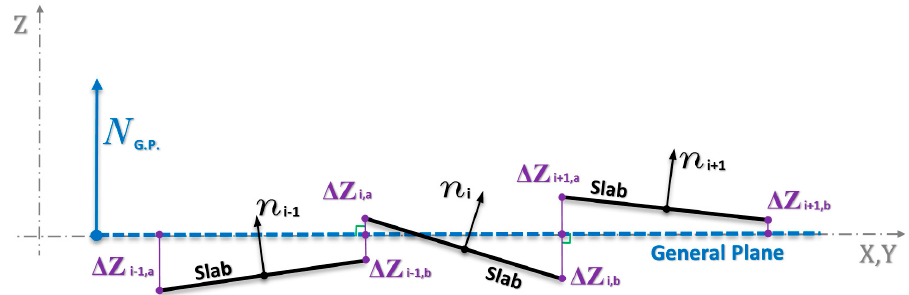
Figure 4. Traces of some slabs and of general plane, normal to the planes, distances Δ Z of the extreme points of the plane-slabs from the general plane (over the joint).